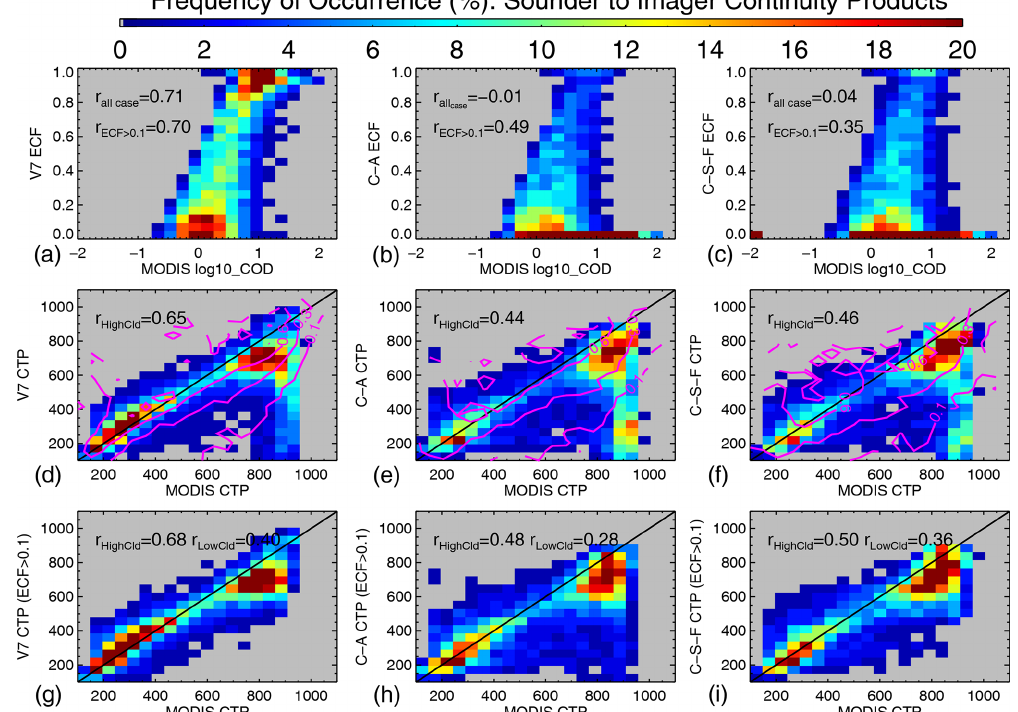
Figure 6. Similar to Fig. 5, except using the MODIS continuity cloud product